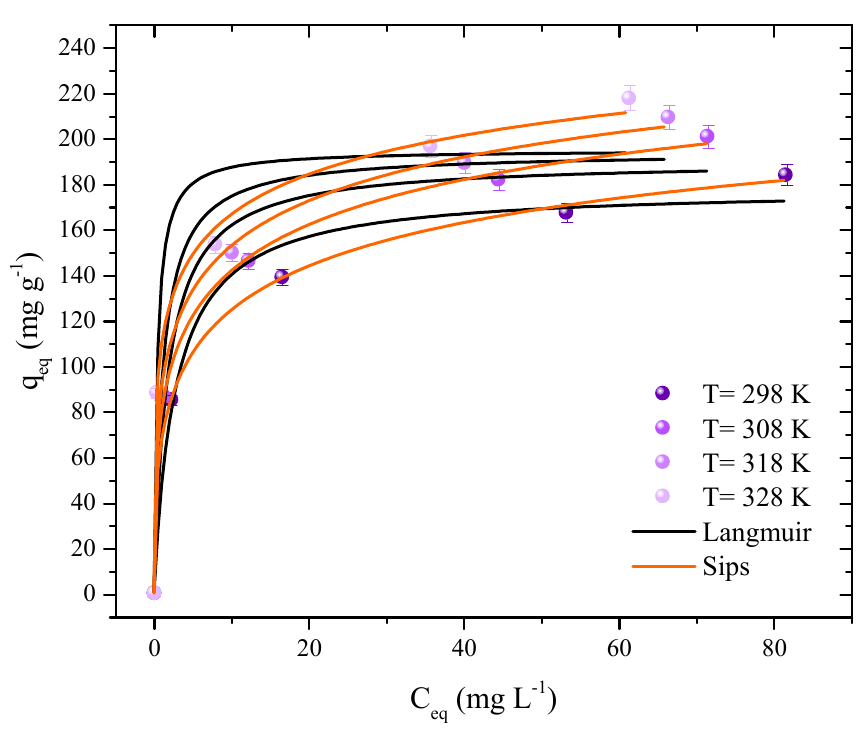
Figure 7. Isothermal adsorption curves of 2,4–D in AC (adsorbent dosage = 0.6 g L − 1 , natural pH of the solution, V = 50 mL and stirring rate = 180 rpm). Table 1. Isothermal parameters for 2,4-D adsorption in